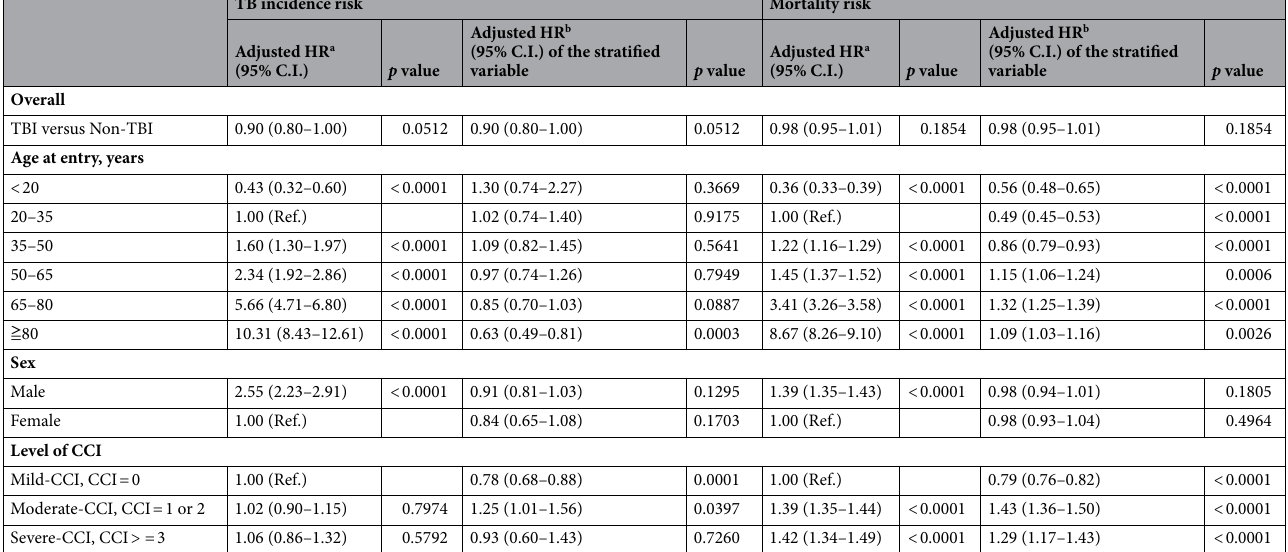
Table 2. The risk of tuberculosis and mortality in patients with intracranial injury compared to patients without TBI in ICU for whole model and the stratified models. TBI traumatic brain injury, ICU intensive care unit, CCI Charlson’s comorbidity index, HR hazard ratio, CI confidence interval. a Adjusted by the variables of age, gender, the length of stay, the length of ICU stays, and level of CCI. b Adjusted by the variables of age, gender, the length of stay, the length of ICU stays, and level of CCI, but excluding the stratified variable in the model.